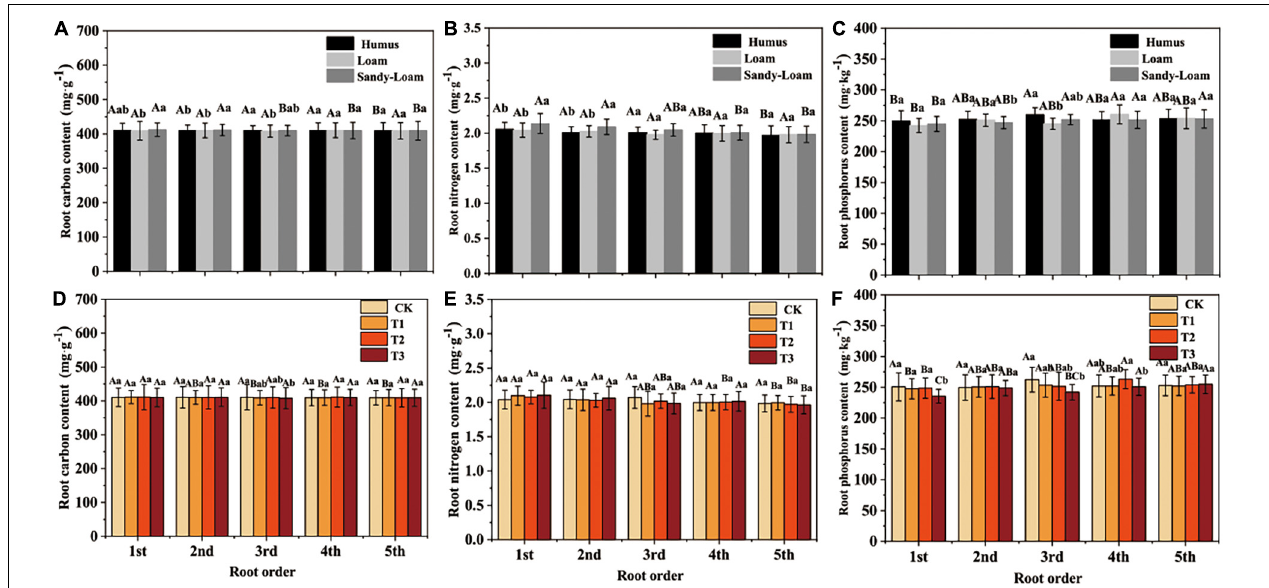
FIGURE 3 | The root carbon (A,D) , nitrogen (B,E), and phosphorus (C,F) of Fraxinus mandshurica seedlings in different soil substrates (A–C) and drought intensity (D–F) . The different lowercase letters denote significant differences among drought intensities ( p < 0.05). The different uppercase letters denote significant differences among root branch order ( p < 0.05).